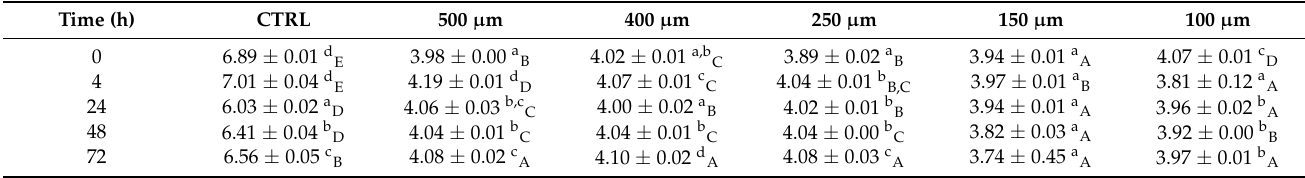
Table 2. Values of pH for broths inoculated with Pseudomonas spp., with and without PPP.